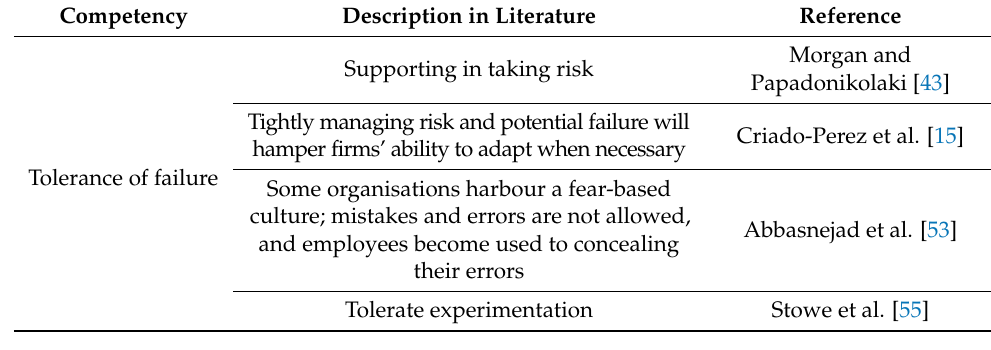
Table 1. Example of competency summary (Tolerance of failure).